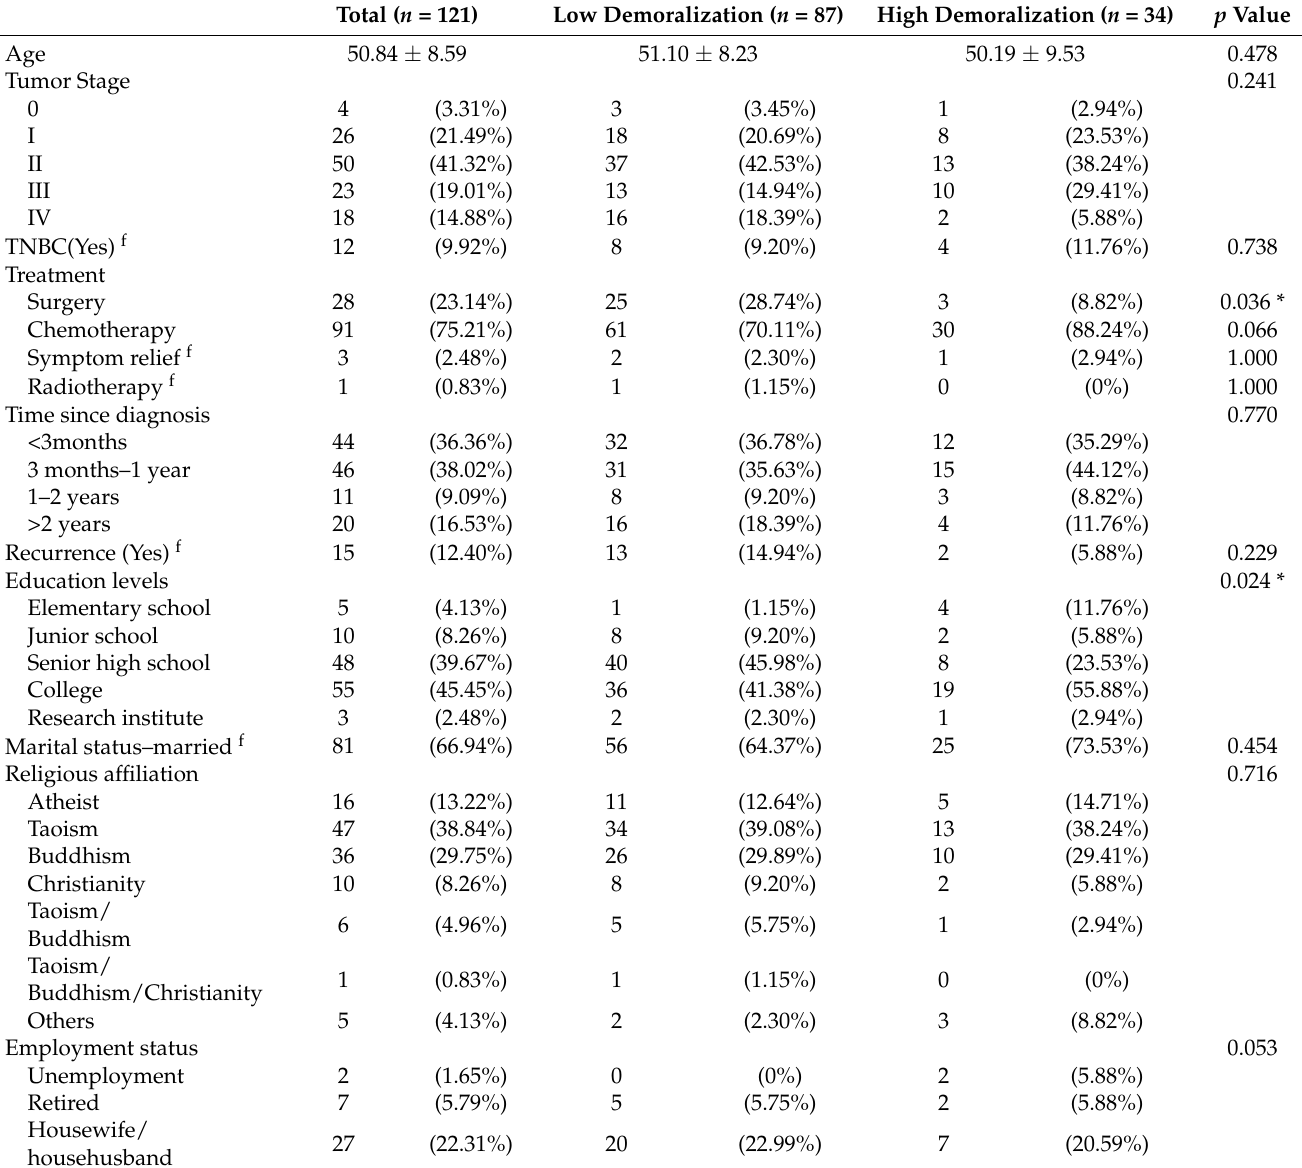
Table 1. The associations between sociodemographic characteristics and